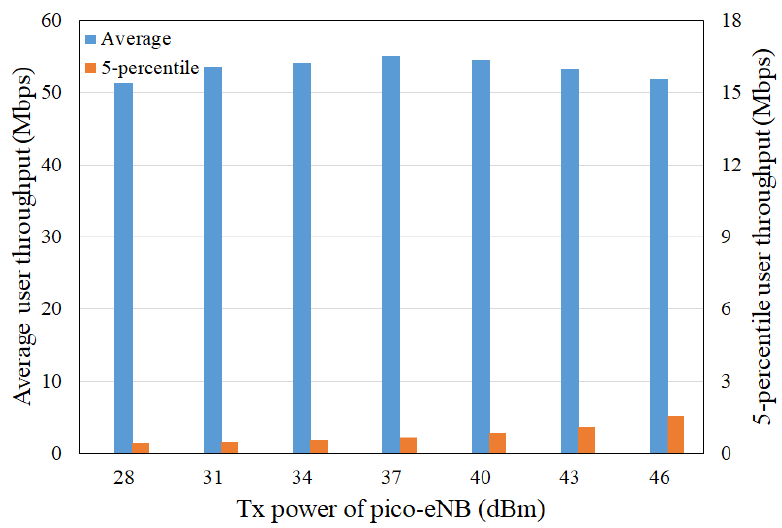
Figure 5. Average and 5-percentile user throughput as a function of pico-eNB Tx power.